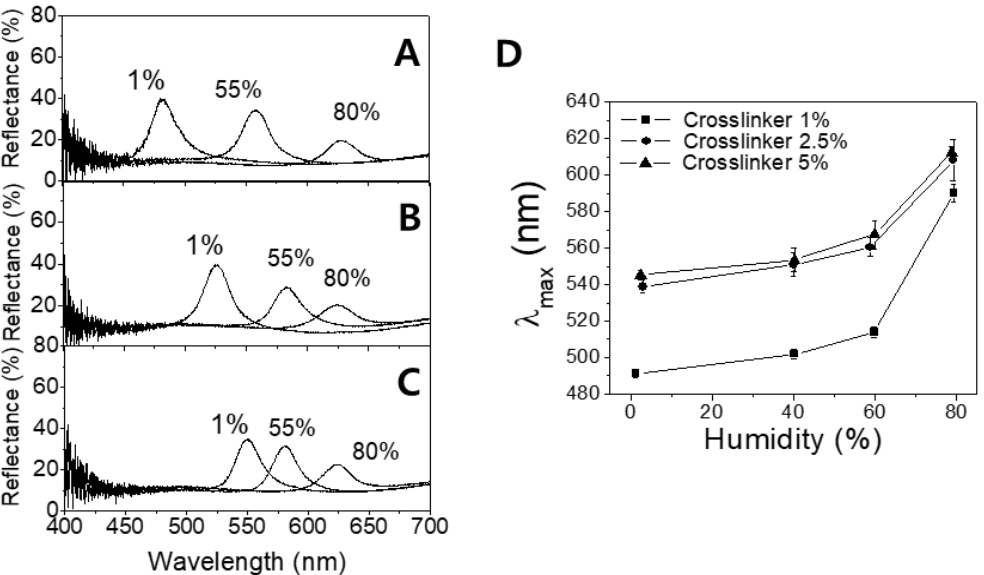
Figure 4. Reflectance spectra of PHEMA IOPGs with different crosslinker contents of ( A ) 1%; ( B ) 2.5%; ( C ) 5%; and ( D ) plot of λ max vs. humidity.